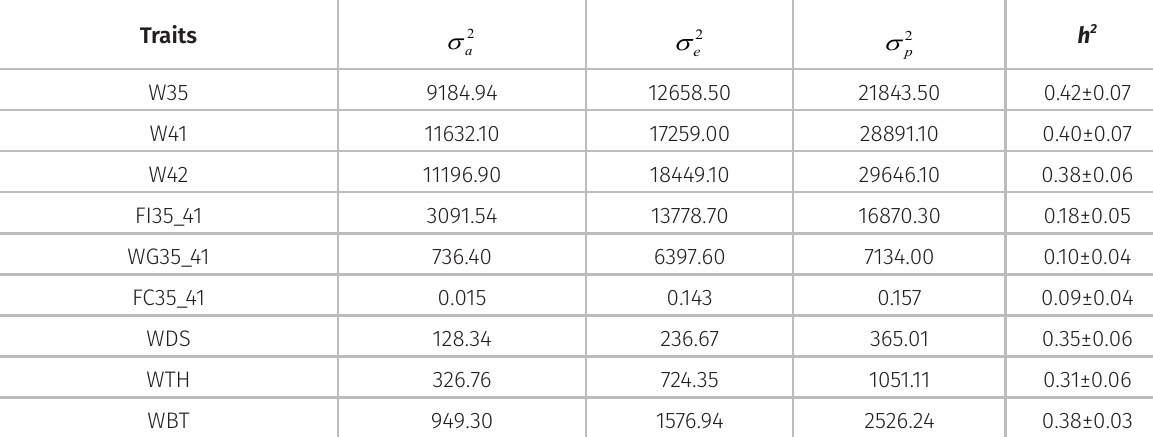
Table II. Estimates of heritability and genetic and environment variance and respective standard error for performance and carcass